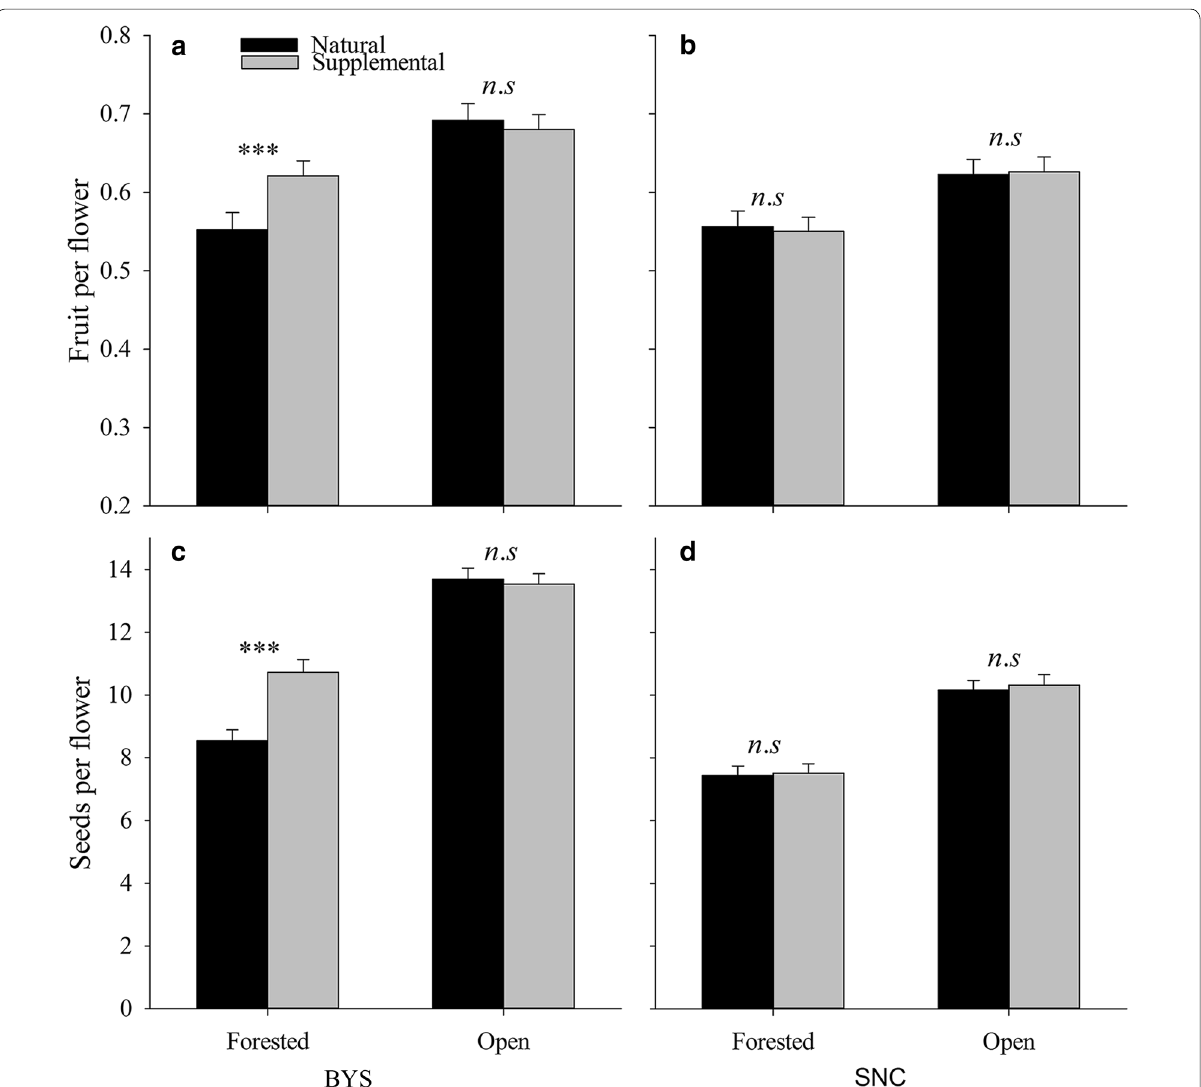
Fig. 2 Fruit ( a , b ) and seeds ( c , d ) per flower (mean SE) for natural and supplemental pollination in the forested and open patches in two popula‑ ± tions of H . ventricosa . n . s not significant, *** P < =